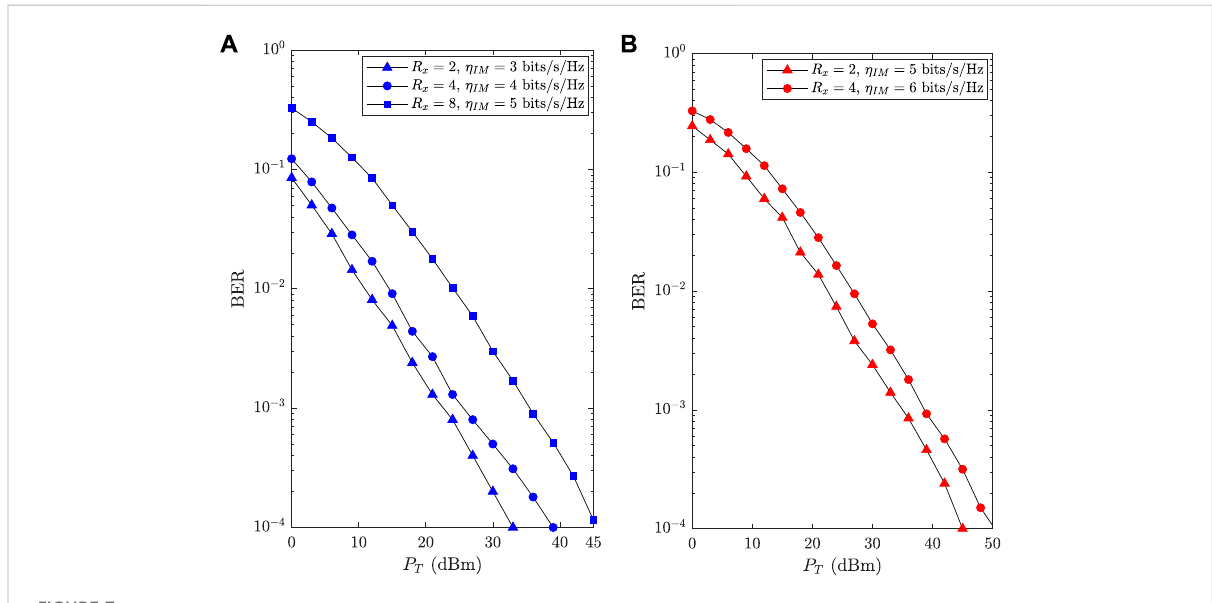
FIGURE 7 BER performance of the novel receive IM scheme with greedy detector for N = 16 and (A) T x = 2, (B) T x = 4.